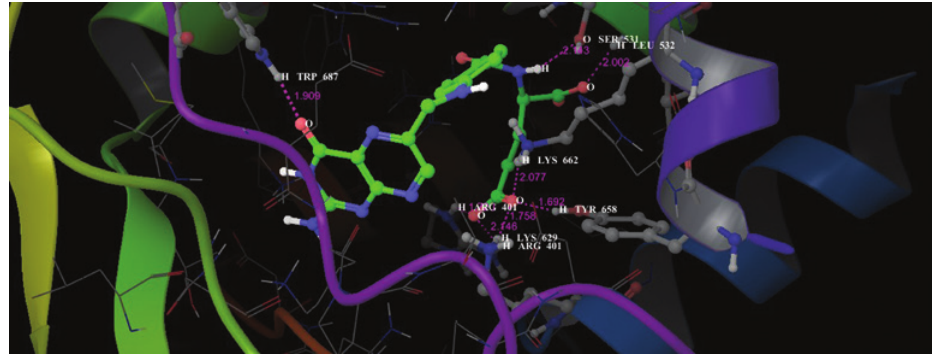
Figure 10: Interaction profile of folic acids and adenosine deaminase in the functional site as ribbon representation.